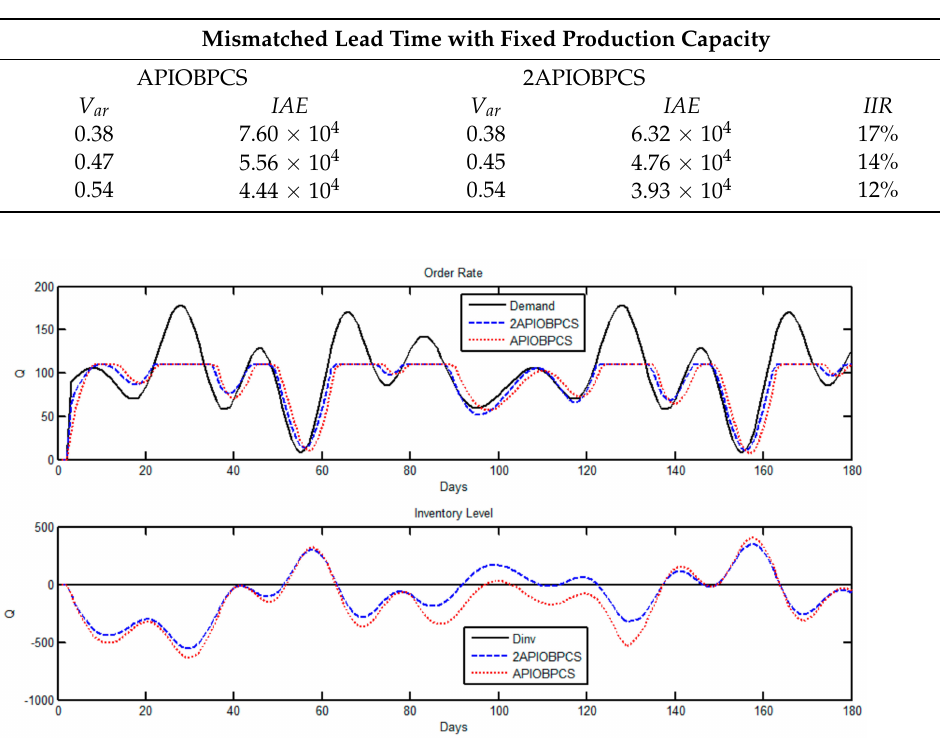
Figure 8. Simulation of Case 4 using Set 2 for the APIOBPCS and 2APIOBPCS models. Order rate ( top ) and inventory level ( bottom